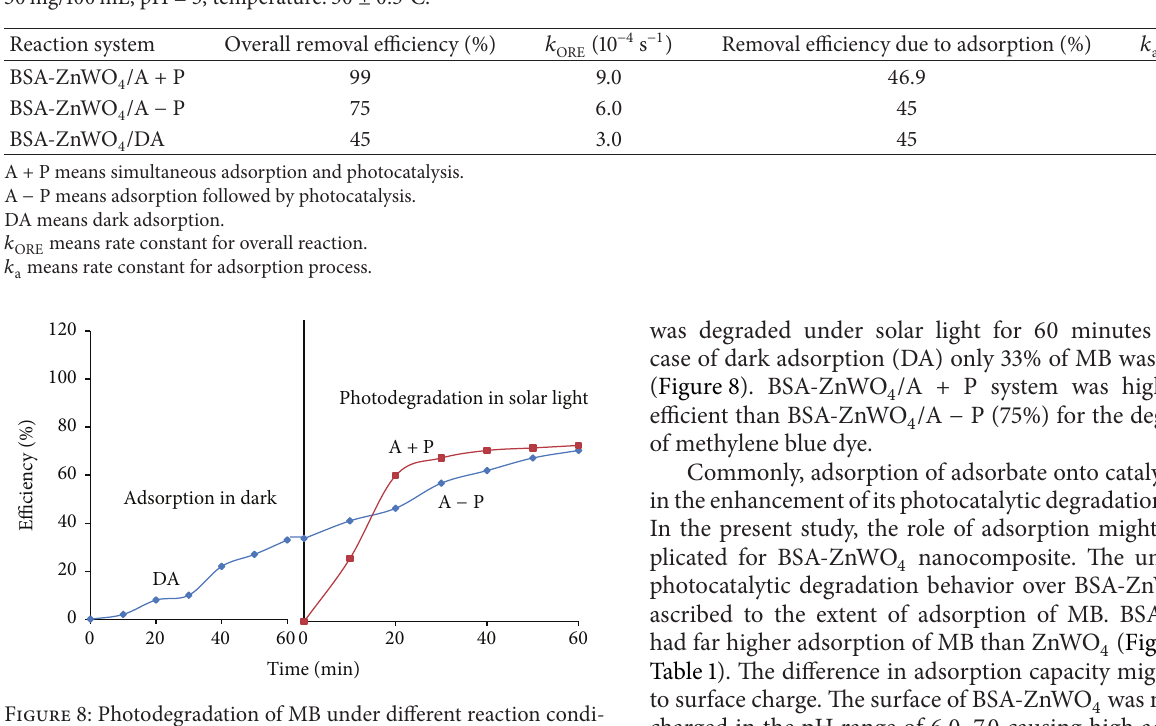
in different reaction systems. [MB] = 6.0 × 10 −5 moldm − 3 , catalyst dosage = 4